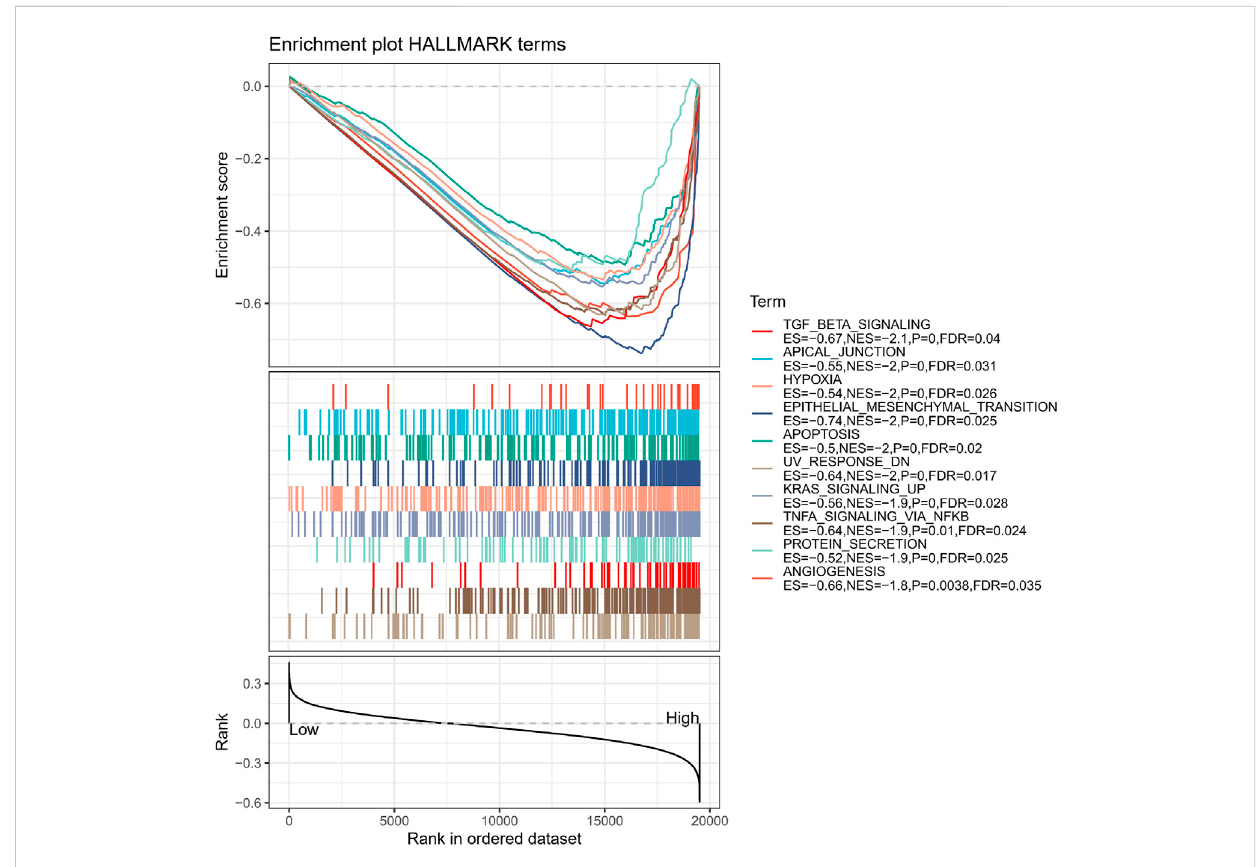
FIGURE 11 Biological pathway characterisation of APR_Score groups via